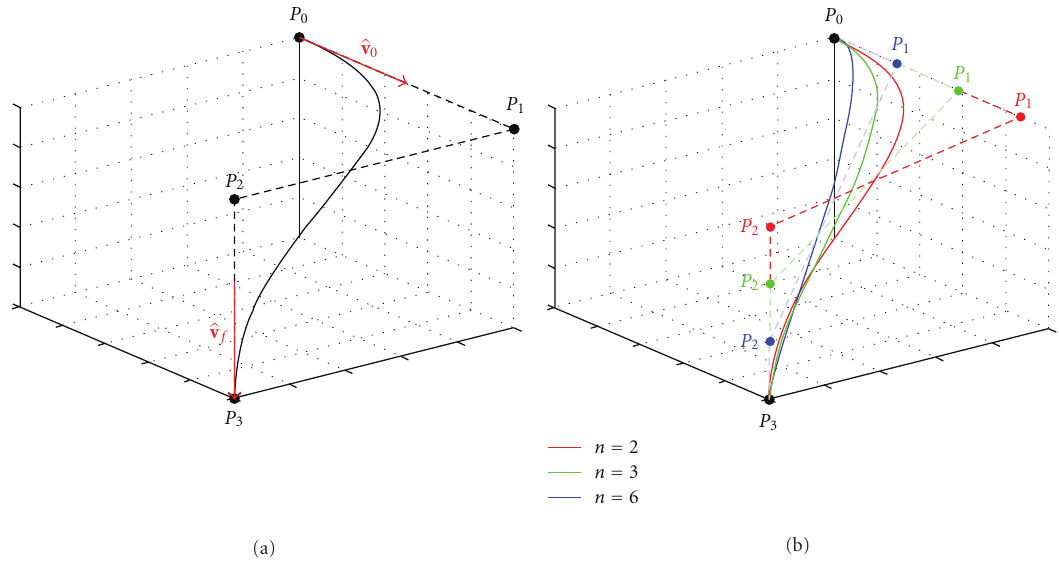
Figure 5: (a) Plot of a cubic 3D Bezi´er curve; (b) influence of the parameter n on the planned trajectory.